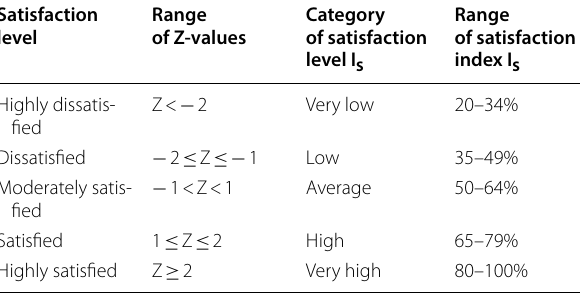
Table 1 Satisfaction categories based on Z-value with SD Satisfaction